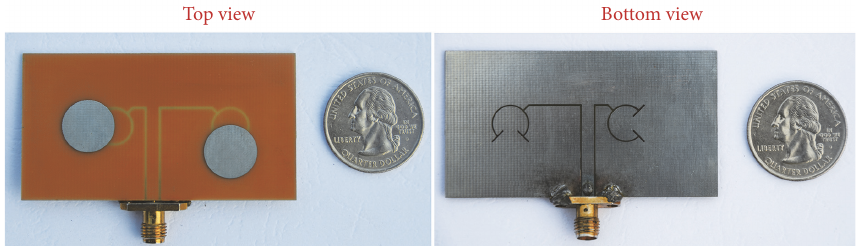
Figure 6: Top view and bottom view of the 1 × 2 linear array.